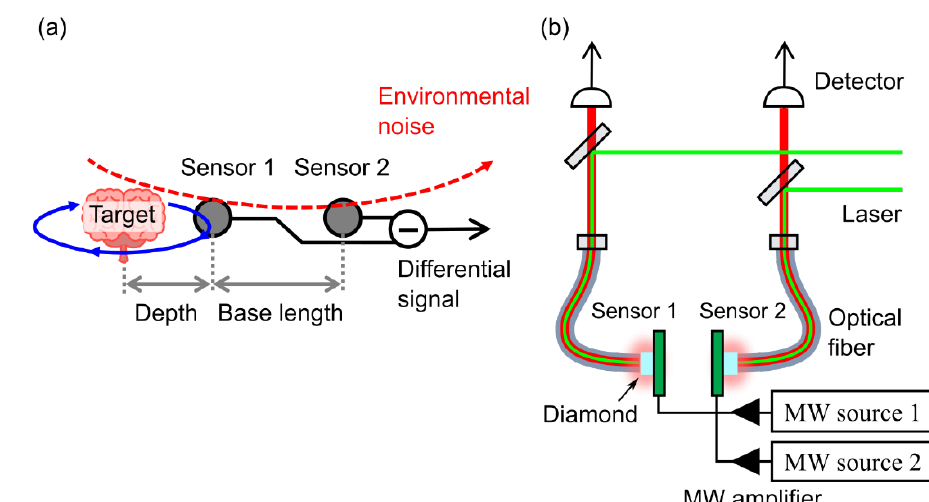
Figure 1. ( a ) Schematic representation of the gradiometer setup. A longer base length than the depth enabled us to selectively detect the target signal. ( b ) A schematic setup of the gradiometer using the nitrogen-vacancy (NV) centers in a pair of diamonds. A dichroic mirror selectively reflected the laser beam and transmitted the fluorescence from NV centers. The fluorescence from each diamond (sensor 1 and sensor 2) was detected by the respective photodiode connected to an oscilloscope.